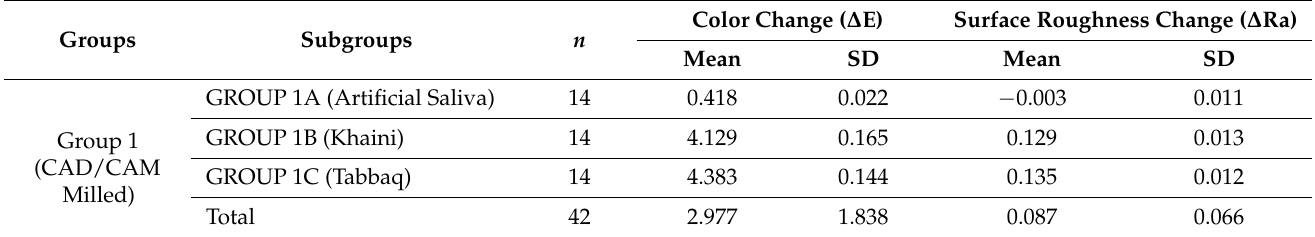
Table 3. Mean color changes ( ∆ E) and surface roughness changes ( ∆ Ra) in all